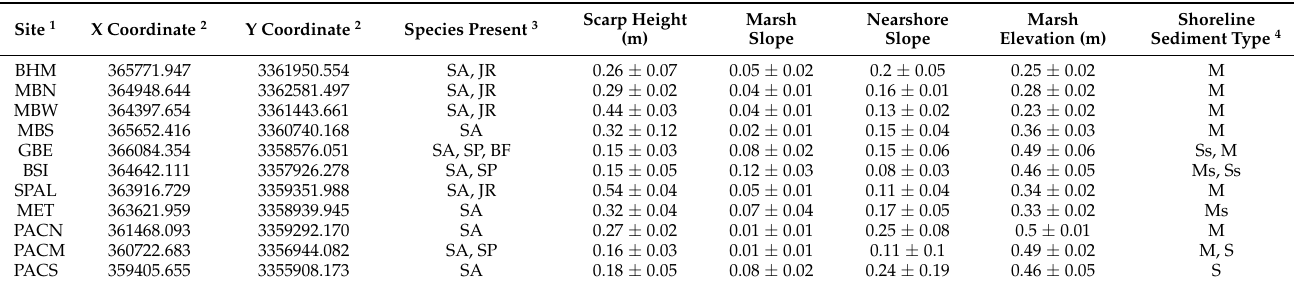
Table 1. Site location, vegetation, elevation, and sedimentary characteristics for the eleven Grand Bay National Estuarine Research Reserve shoreline erosion study